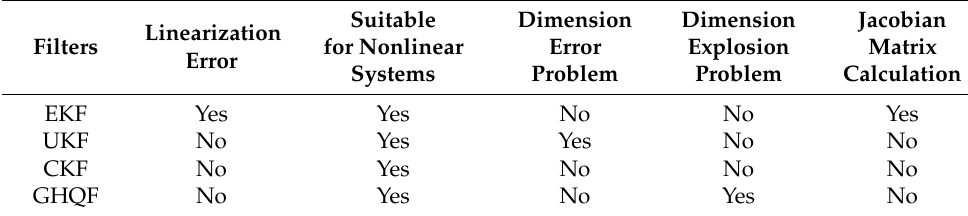
Table 1. Performance comparison of some commonly used filters.